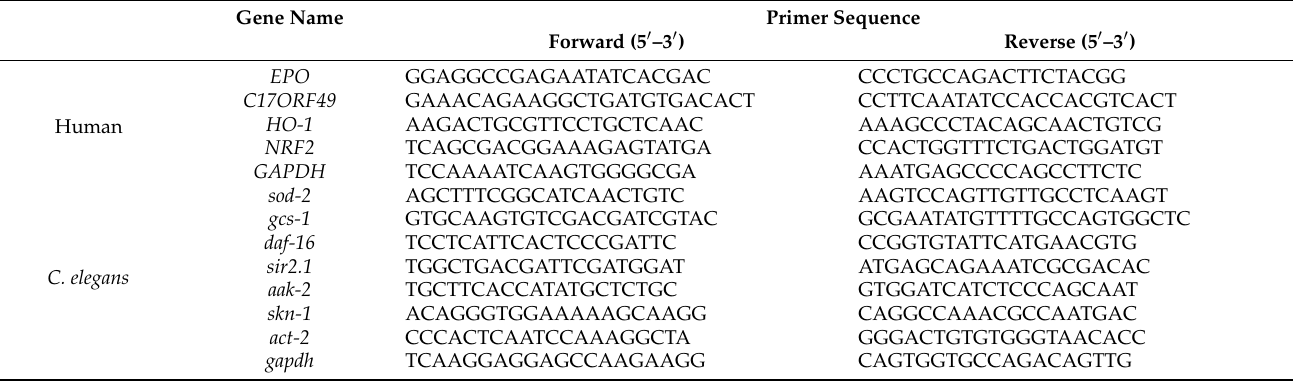
Table 2. Sequences of primers used for RT−PCR.